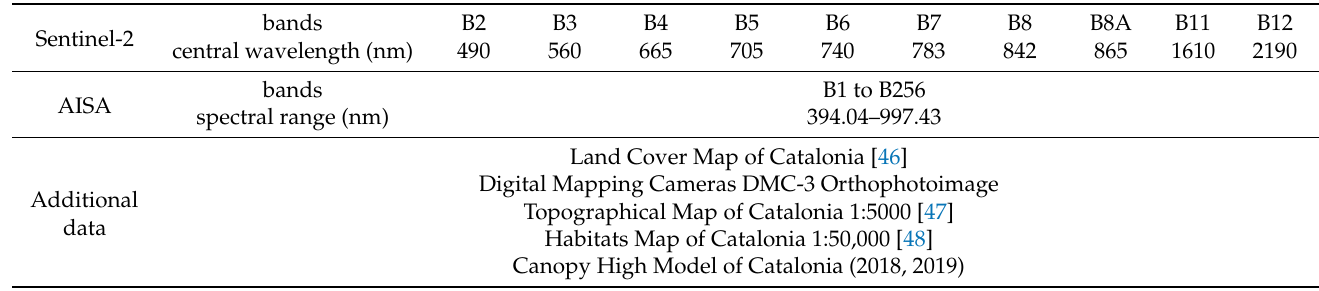
Table 1. Input data used in the